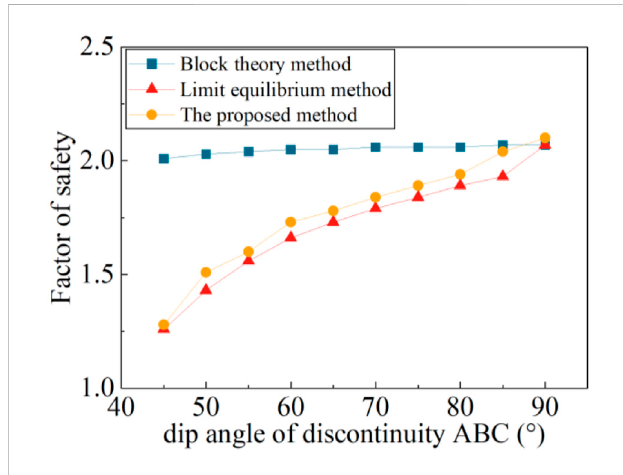
FIGURE 7 Effect of the dip angle of discontinuity ABC on slope stability analysis.